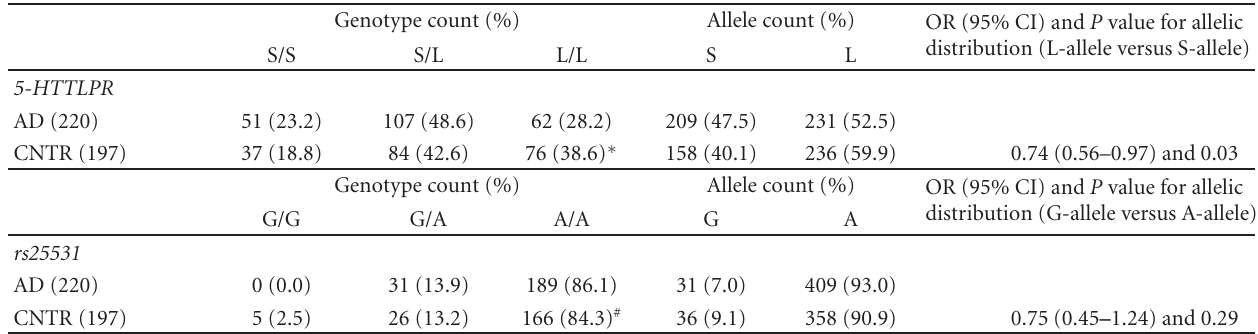
Table 3: 5-HTTLPR and rs25531 genotypic and allelic frequencies. Genotype count (%)